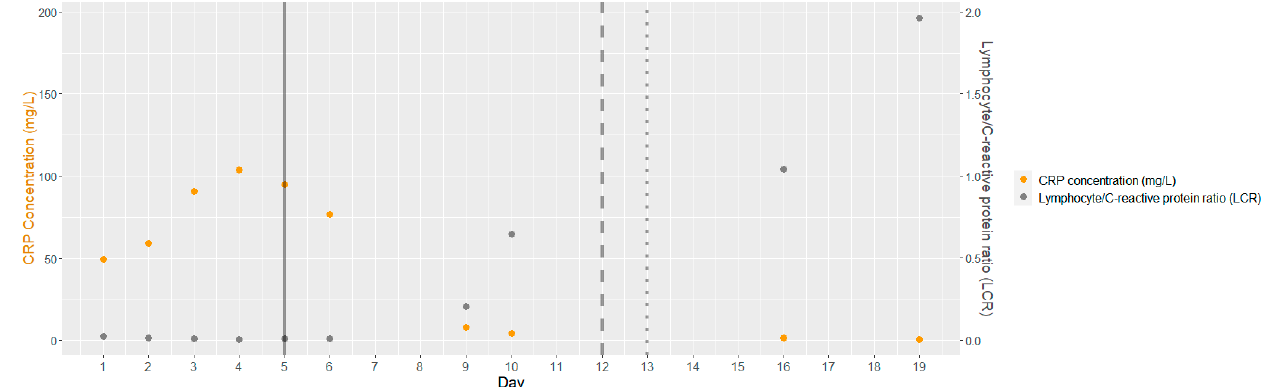
Figure 6. CRP (mg/L) and lymphocyte/CRP ratio levels throughout hospitalization. The solid line denotes transfer to PICU + intubation, the dashed line denotes extubation, and the dotted line denotes discharge from PICU.